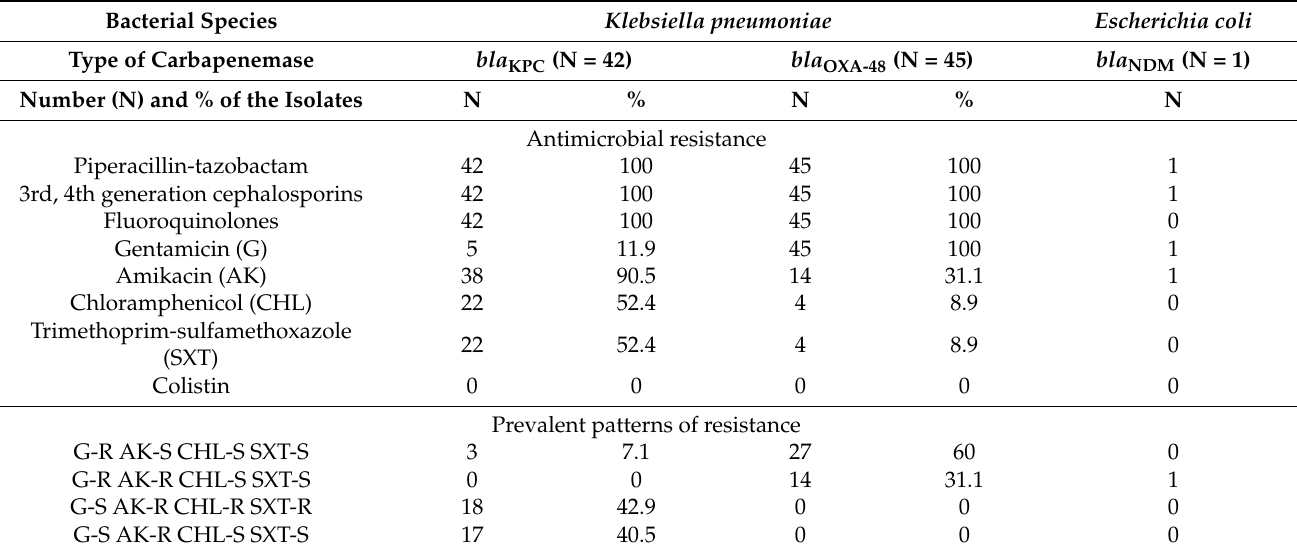
Table 3. Distribution of carbapenemase genes, antimicrobial susceptibility and patterns of antimicro- bial